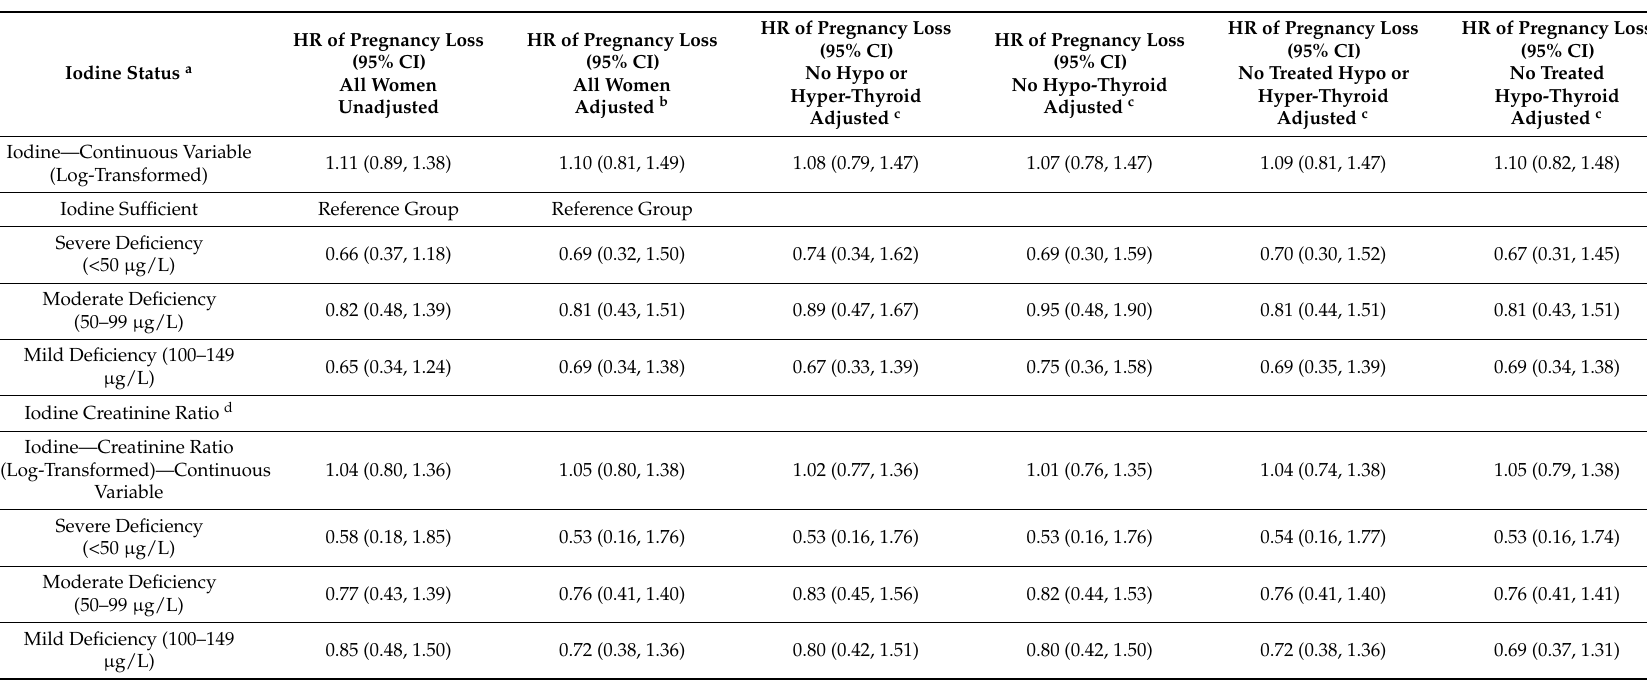
Table 3. Hazard ratio (HR) of loss in women becoming pregnant by iodine status (ratio <1 indicates reduced risk)—reference group—iodine sufficient women ( n = 329).